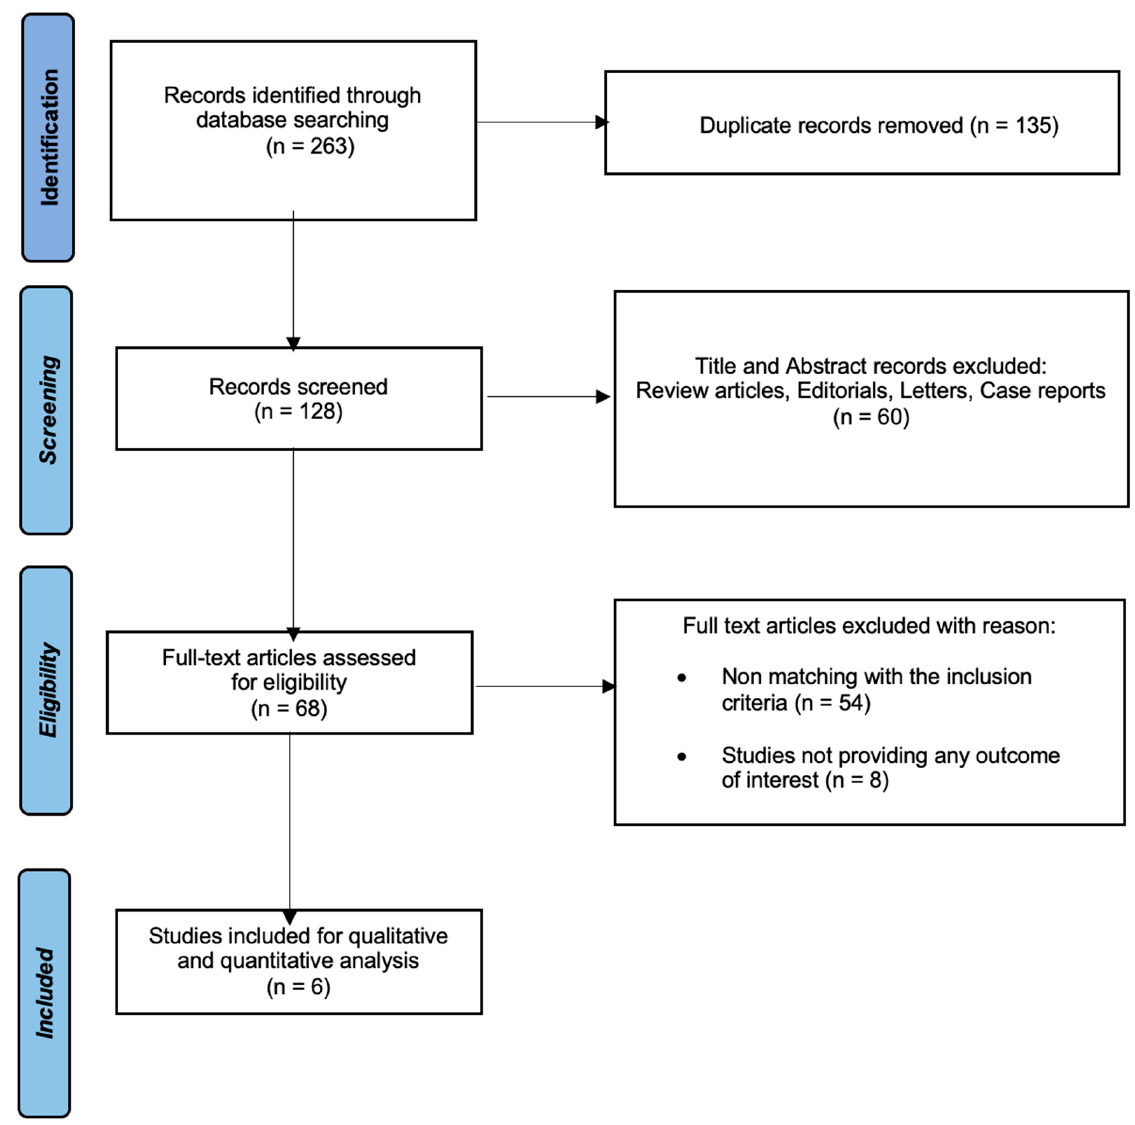
Figure 1. Study flow chart. Table 1. ( a , b ) Summary of published research: Baseline characteristics among eligible studies testing the diagnostic per- formance of preoperative CEUS. ( a ) Neoplastic vs.